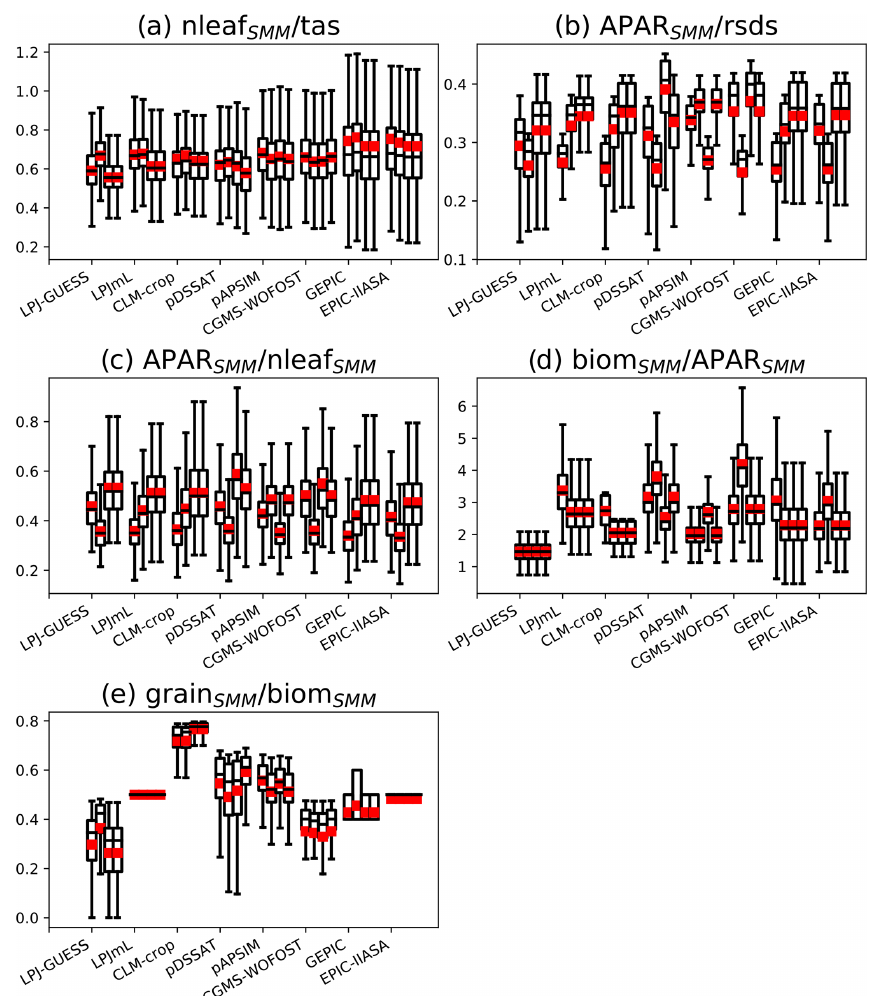
Figure 8. Bar plots of different ratios computed with SMM calibrated against each GGCM. Each panel shows a ratio ( a n leaf / tas, b APAR / rsds, c APAR /n leaf , d biom / APAR, e grain / biom), while for a given panel x axis ticks correspond to emulated GGCMs. Four different ( C , RUE) pairs have been tested and correspond to the four bars of each x axis